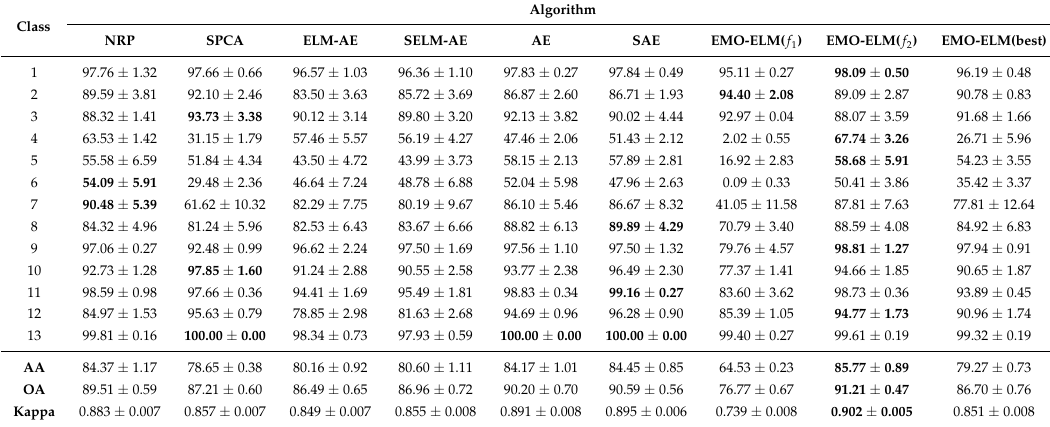
Table 4. The performance comparison of KSC for NRP, SPCA, ELM-AE, SELM-AE, AE, SAE and EMO-ELM. (MEAN ± STD) L = 10, iter = 5000, ρ = 0.05, NP = 50.